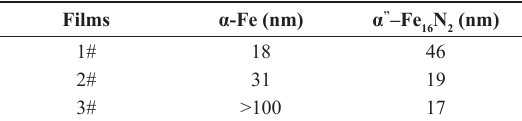
Figure 4. XRD patterns of the iron nitride films.